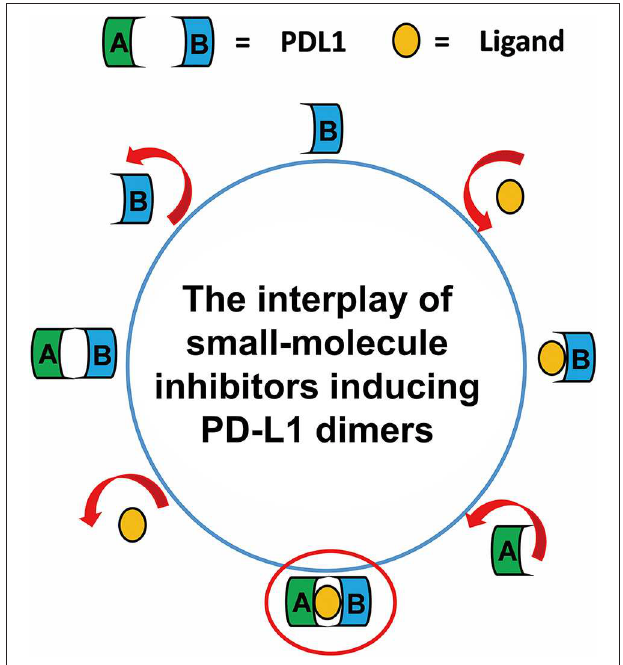
FIGURE 8 | The complete binding and unbinding mechanism of BMS small-molecule inhibitors. The conformation A and conformation B of PD-L1 monomer, the small-molecule ligand are represented by green, light blue, orange objects,